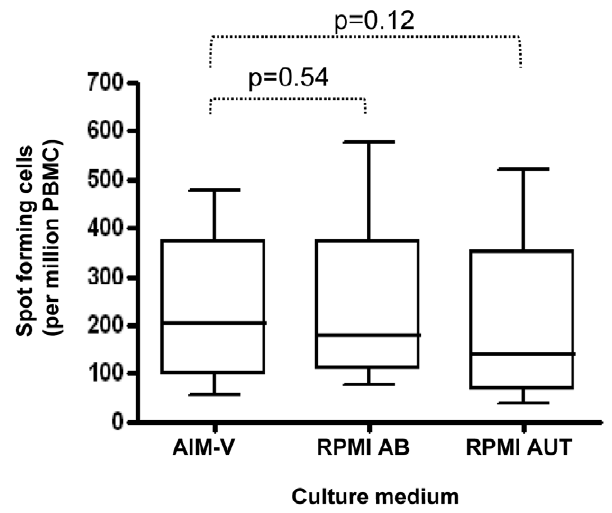
Figure 2. A comparison of the effects of different culture media used in ELISpot assays. Spot numbers in un-stimulated and in M.tb PPD stimulated ex vivo ELISpot assays were determined following the use of different culture media (AIM-V serum-free medium; RPMI 1640 medium supplemented with heat inactivated human pooled AB serum (RPMI AB) or RPMI 1640 medium supplemented with autologous serum (RPMI AUT). Results are SFC per million PBMC in M.tb PPD-stimulated samples minus that measured in medium only samples. Box and whisker plots show the median, upper and lower quartiles and range of the response (n=8). Statistical analysis is by paired